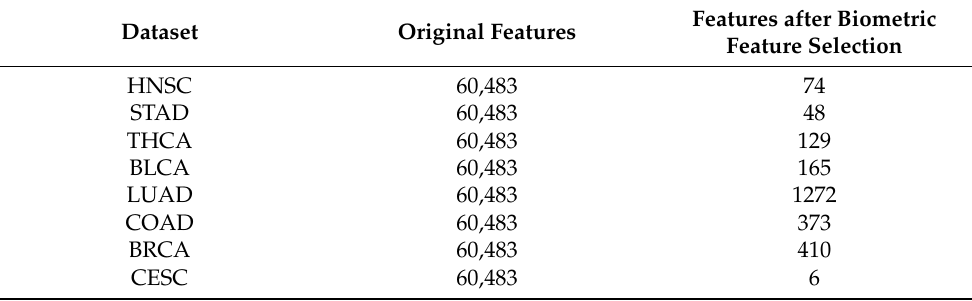
Table 2. The numberof sample features obtained by biometric feature